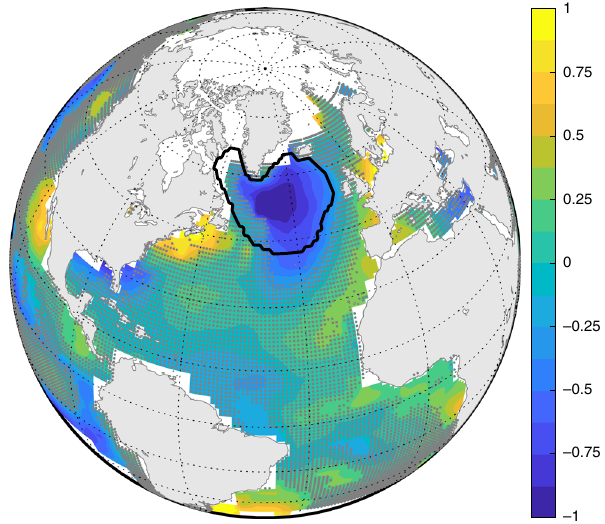
Fig. 7 Changes in sea-surface temperature. Shading shows trends in sea- surface temperature over 1909 – 2018 ( ∘ C century − 1 ) averaged over two products: HadISST 69 and Kaplan 70 . Stippling indicates that the magnitude of the trend is less than twice the standard error estimated taking into account autocorrelation of the residuals 59,60 as described in the Supplementary Information. The black contour outlines the warming-hole region of Caesar et al. 24 . Note that the time series of global-ocean area- averaged sea-surface temperatures has been removed before computing trends.